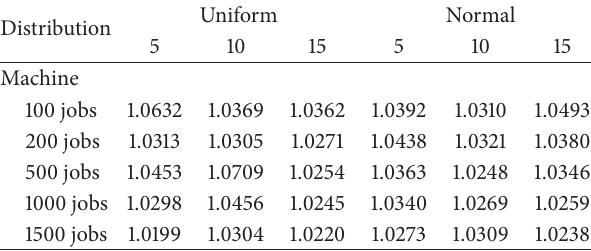
Table 2: Results of